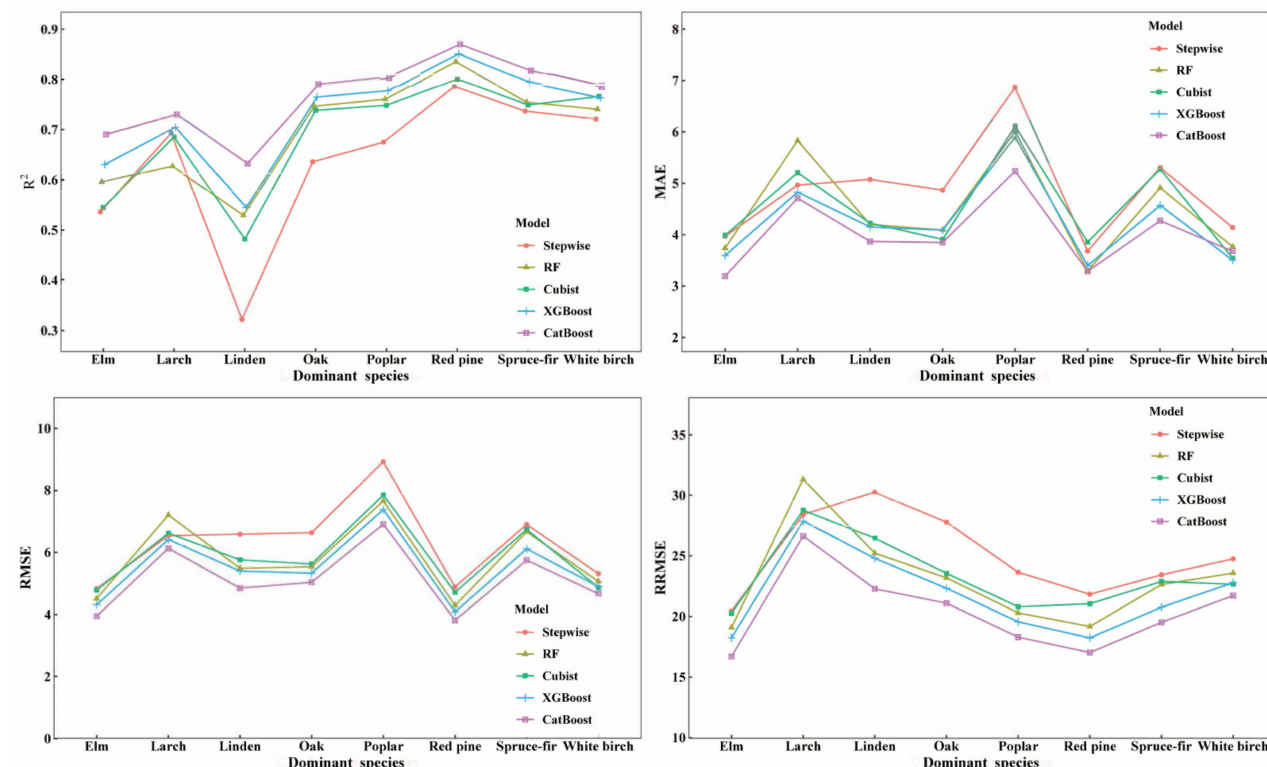
Figure 5. Model estimation accuracy evaluation results based on the validation datasets using stepwise regression and four ML algorithms in eight different dominant